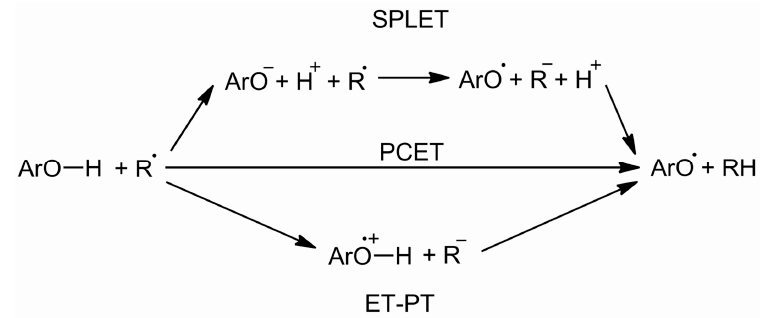
Figure 2. Different mechanisms for hydrogen atom transfer from polyphenols (ArO–H).